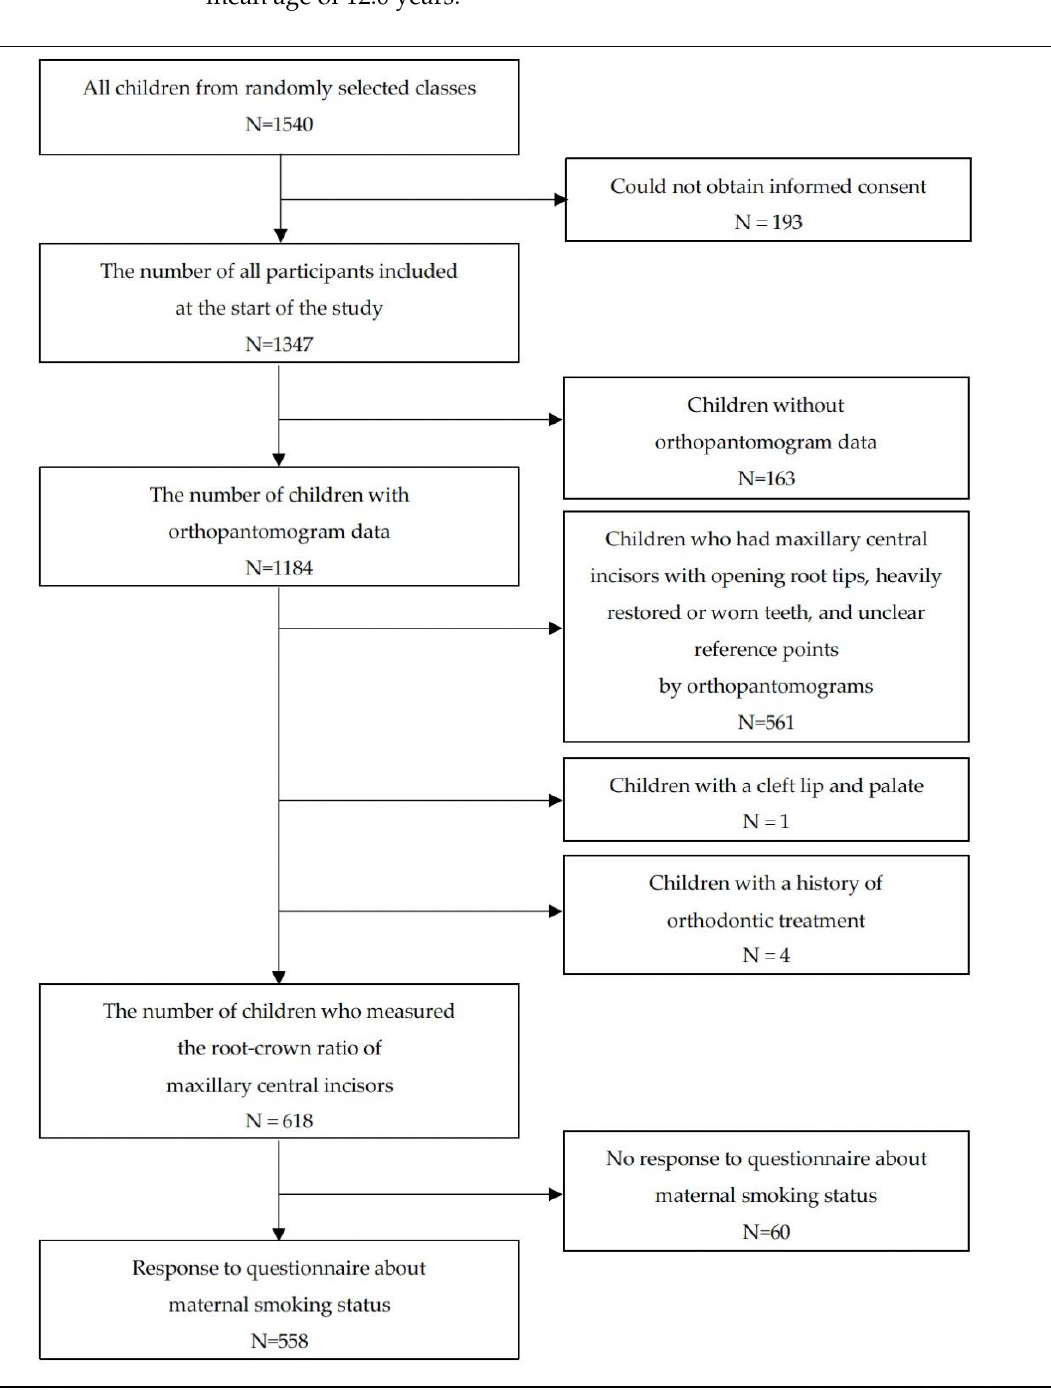
Figure 1. Flow chart of the sample selection process.